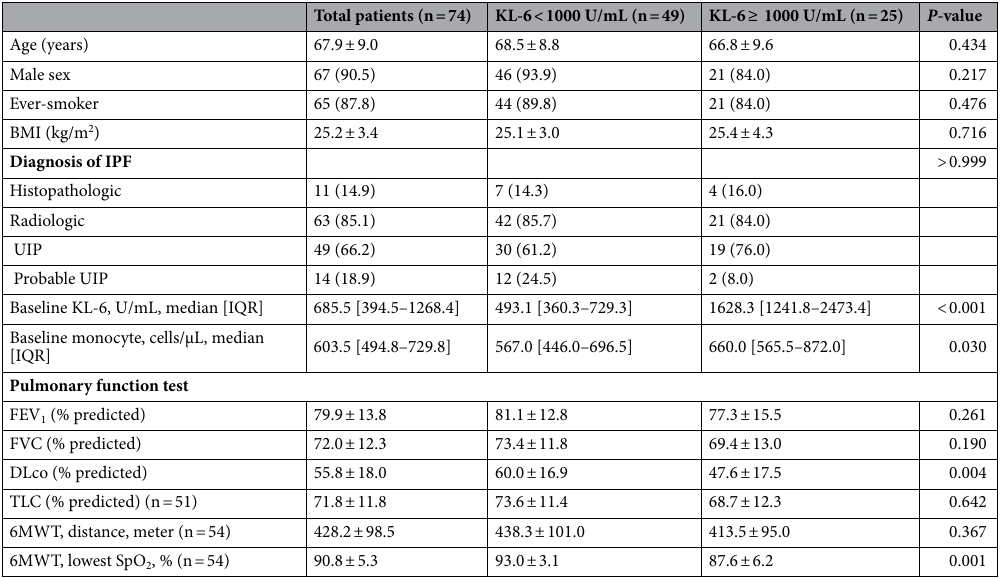
Table 2. Comparison of baseline characteristics in the serum KL-6 < 1000 U/mL vs. KL-6 ≥ 1000 U/mL group. Data are presented as the mean ± standard deviation or number (%), unless otherwise indicated. BMI: Body mass index, IPF: Idiopathic pulmonary fibrosis, UIP: Usual interstitial pneumonia, KL-6: Krebs von den Lungen-6, IQR: Interquartile range, FEV 1 : Forced expiratory volume at 1 s, FVC: Forced vital capacity, DLco: Diffusing capacity of the lung for carbon monoxide, TLC: Total lung capacity, 6MWT: 6-min walk test, SpO 2 : Saturation of percutaneous